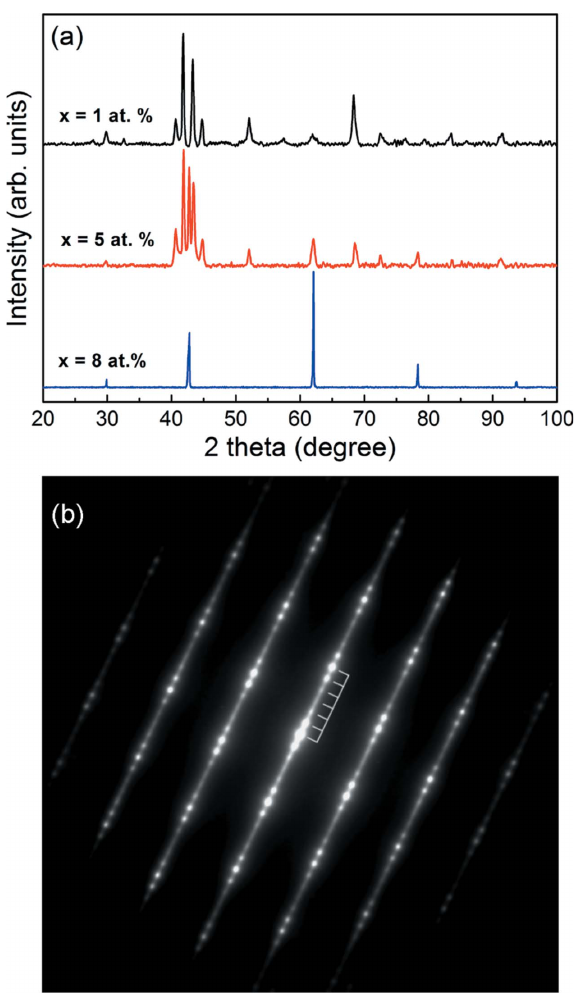
Figure 1 ( a ) Room-temperature XRD patterns for Mn 50 Ni 41 Co 1 Sn 8 ( x = 1), Mn 50 Ni 37 Co 5 Sn 8 ( x = 5) and Mn 50 Ni 34 Co 8 Sn 8 ( x = 8) ribbons. ( b ) Selected-area electron diffraction pattern for 6 M martensite of Mn 50 Ni 41 Co 1 Sn 8 ribbons along h 210 i M